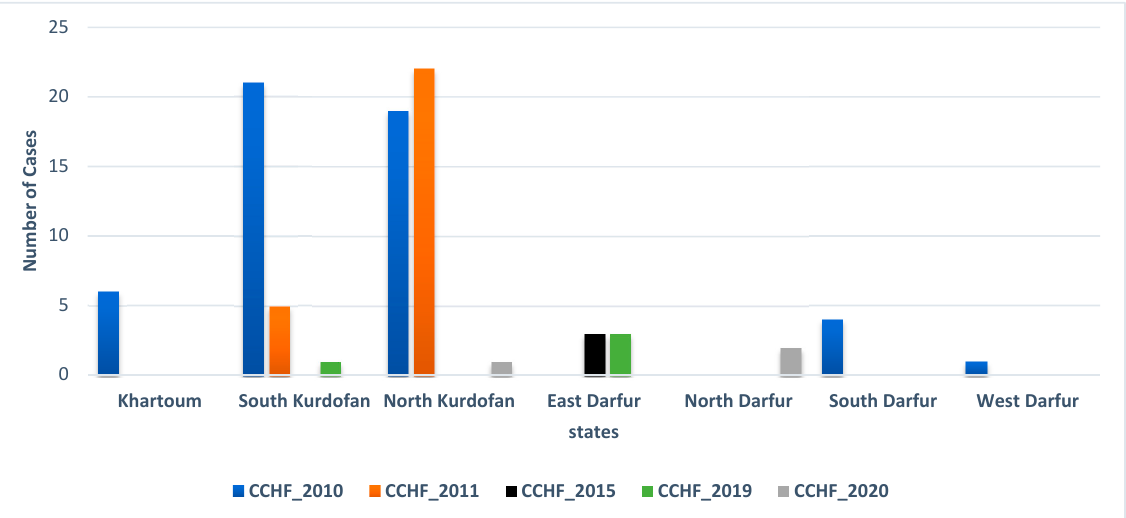
Figure 3. Number of Crimean-Congo hemorrhagic fever (CCHF) cases reported during each epidemic per